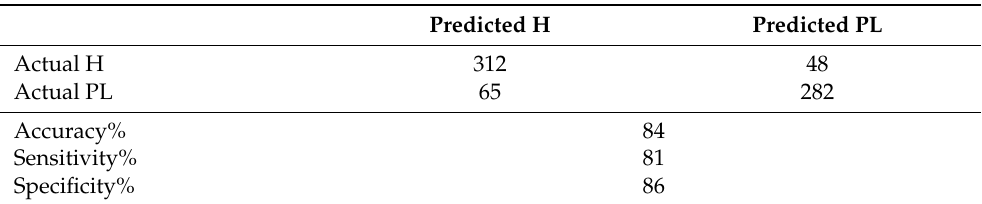
Table 3. Confusion matrix and classification metrics assessing the final performance of Inception v3 on the test set.